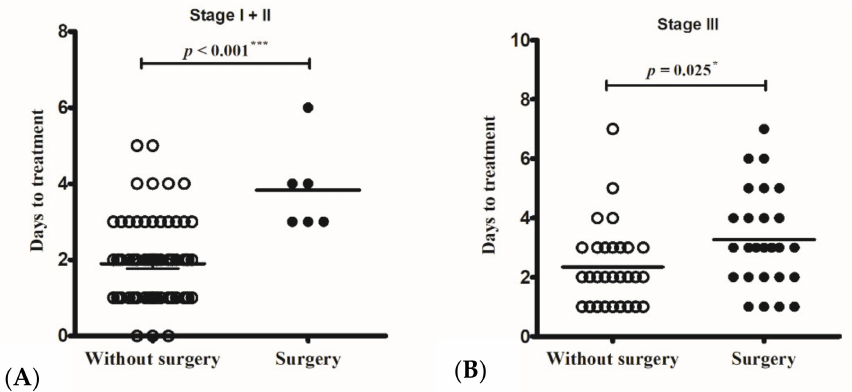
Figure 1. The only operated Chandler I case and the five operated Chandler II cases all started intravenous antibiotic therapy more than three days from symptom onset, whereas non-operated cases started intravenous antibiotic therapy less than two days from symptom onset ( p < 0.001) ( A ). Non-operated Chandler III cases had intravenous antibiotic therapy (2.34 ± 1.40 days) earlier than those with surgical intervention (3.27 ± 1.66 days) ( p = 0.025) ( B ). * p < 0.05; *** p < 0.001.